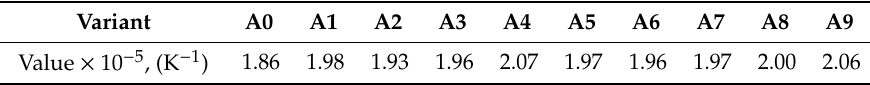
Figure 13. Dilatometric curves for heating at 0.08 °C/s. Table 6. Thermal expansion coefficients of the modified Inconel 740 superalloys.